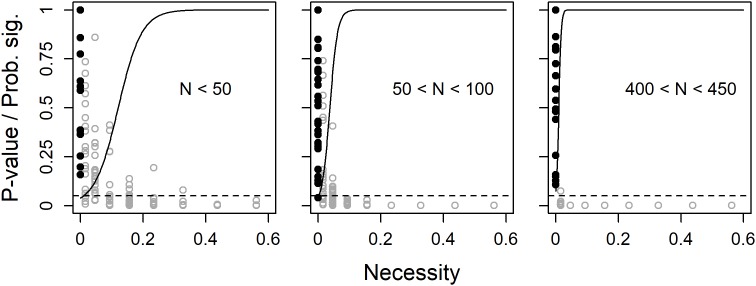
Observed p-values (dots) and predicted probability for a significant (p < 0.05) necessity effect (solid line) as functions of true population necessity effect, separately for three ranges of sample size. The filled black dots are observed p-values when true degree of necessity = 0 and the dashed line shows the limit for p < 0.05.